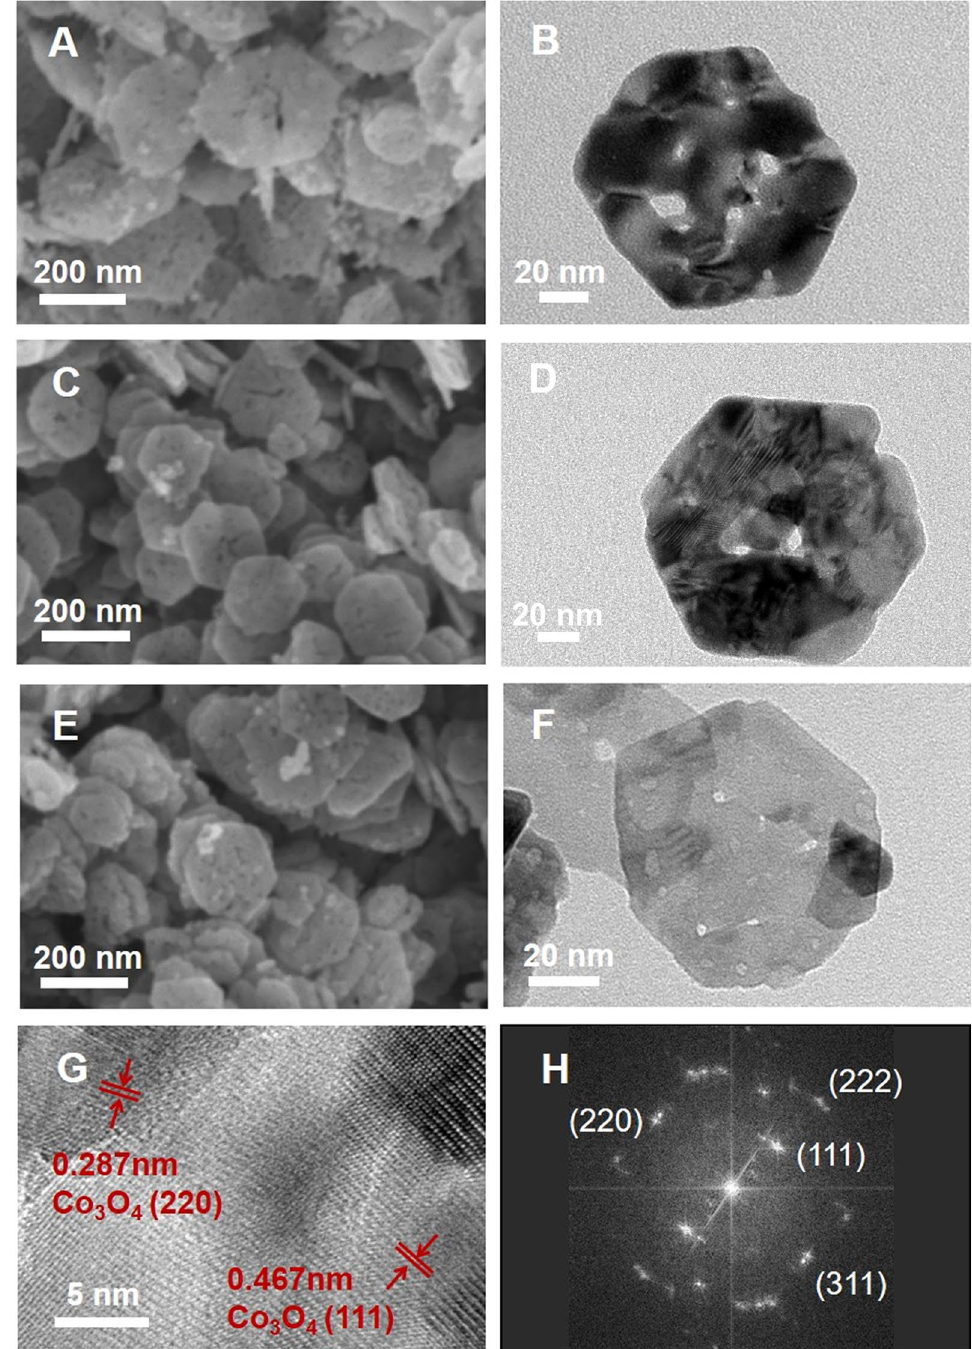
Figure 1. FE-SEM images ( A , C , E ) and TEM images of ( B , D , F ) of Co 3 O 4 ( A , B ), CoGO100 ( C , D ) and CoGO50 ( E , F ). ( G ) HRTEM image and ( H ) the corresponding SAED pattern of